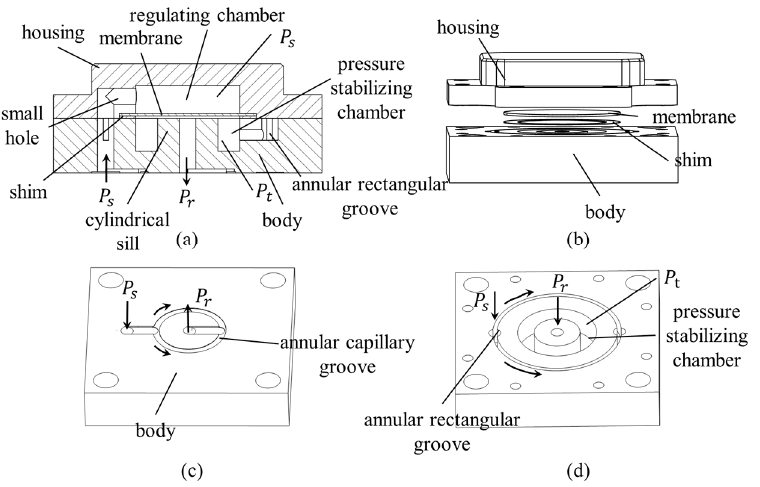
Figure 1. Structure of PSMR. ( a ) The sectional view of PSMR; ( b ) Parts of the PSMR; ( c ) Structure of the front side of the body; ( d ) Structure of the back of the body.